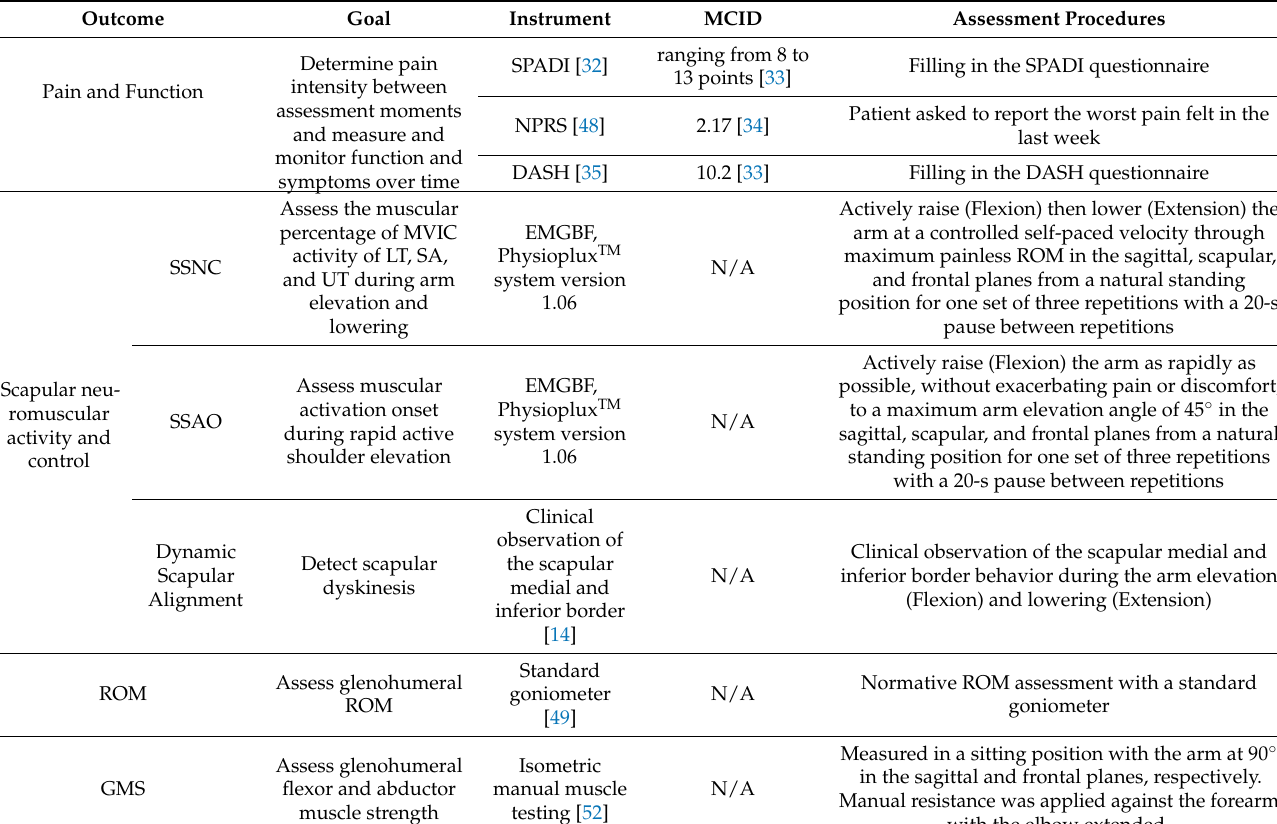
Figure 2. Scapular-focused exercise protocol flow diagram. Table 2. Resume of testing procedure.